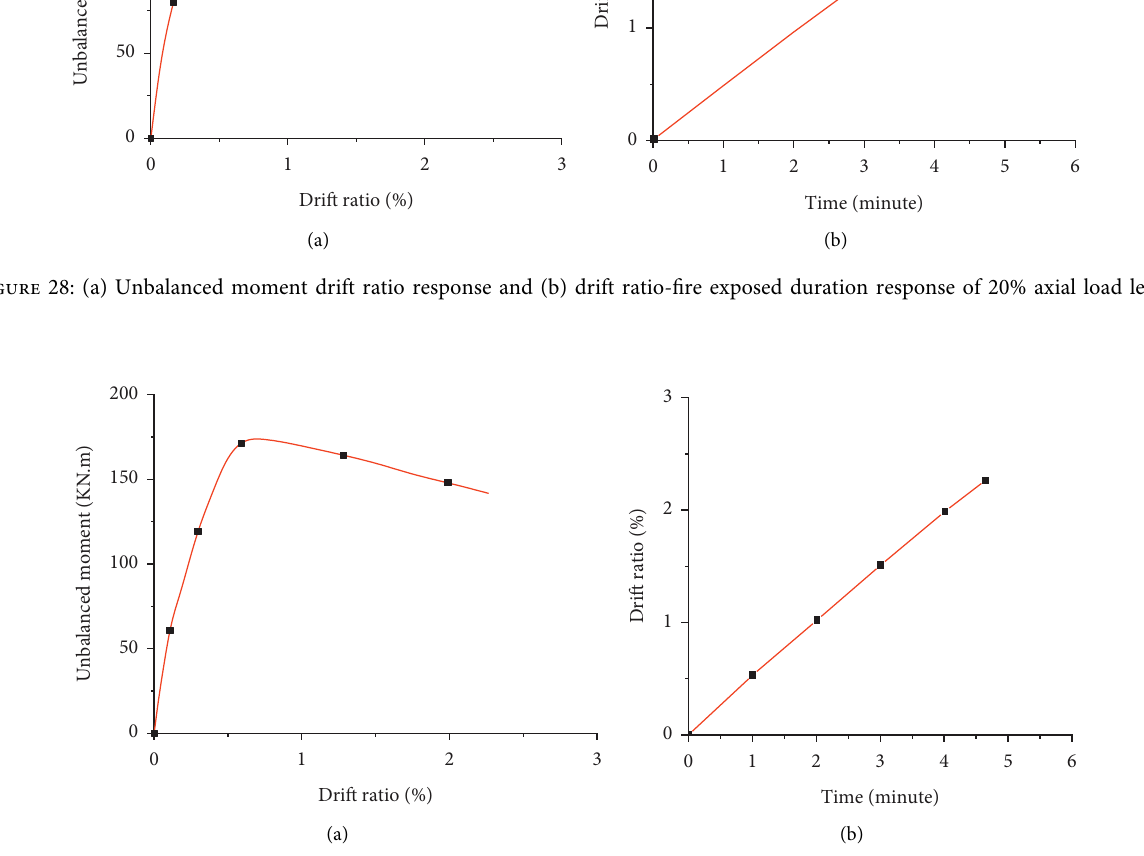
Figure 29: (a) Unbalanced moment drift ratio response and (b) drift ratio-fre exposed duration response of 50% axial load